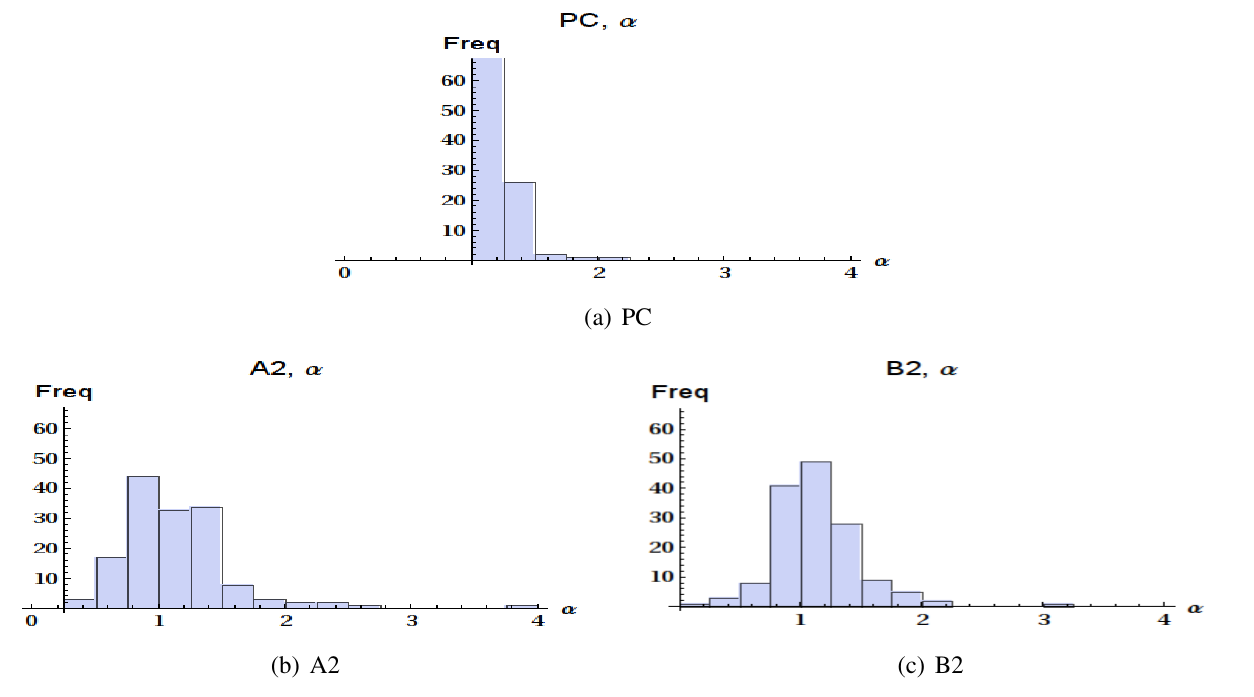
Figure 7. Distributions of the values of the α parameter of Equation (1). All the histograms have been produced to represent the same number of samples, but the one of panel 8(a) has been cut to make easier a comparison with the other panels, using the same vertical scale; it shows a very high peak on α ∼ 1 (up to 120) due to the choice of data normalization (see Section